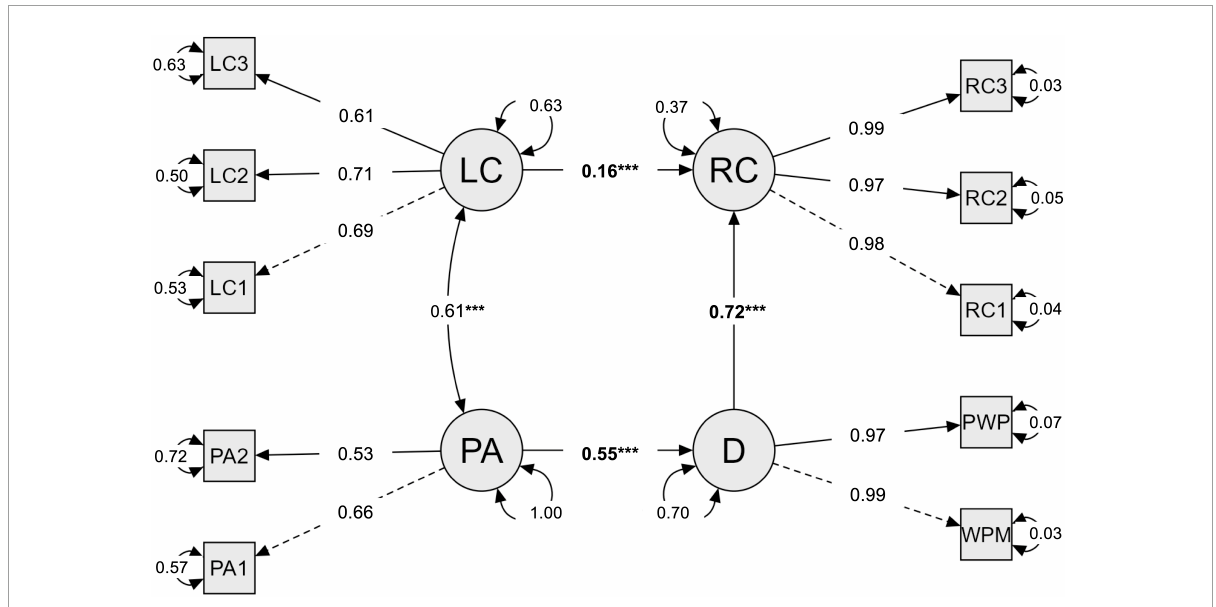
FIGURE3 Standardized parameter estimates for the structural equation models with second-grade children. *** p < 0.001. D, Word recognition; RC, Reading comprehension; PA, Phonological awareness; LC, Language comprehension; WPM, Words per minute (correct); PWP, pseudowords per minute